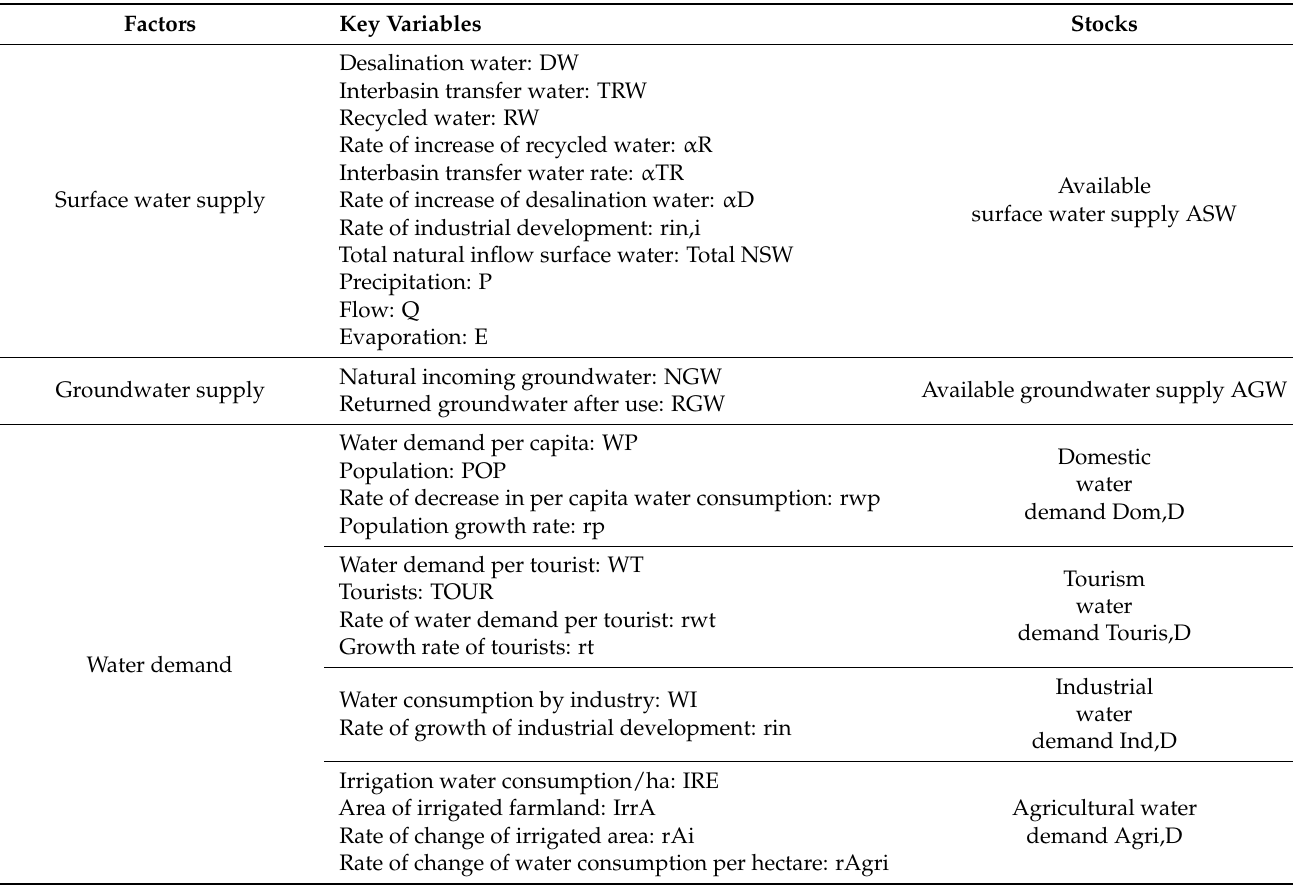
Table 1. Variable and constant parameters integrated in the System Dynamics